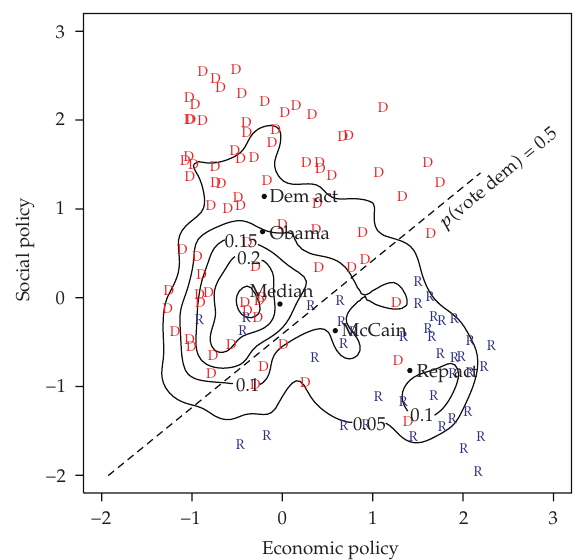
Figure 5: Smoothed voter distribution; candidate positions and activist positions in 2008. (cid:2) Democrat activists are red and Republican activists are blue, together with cleavage line.